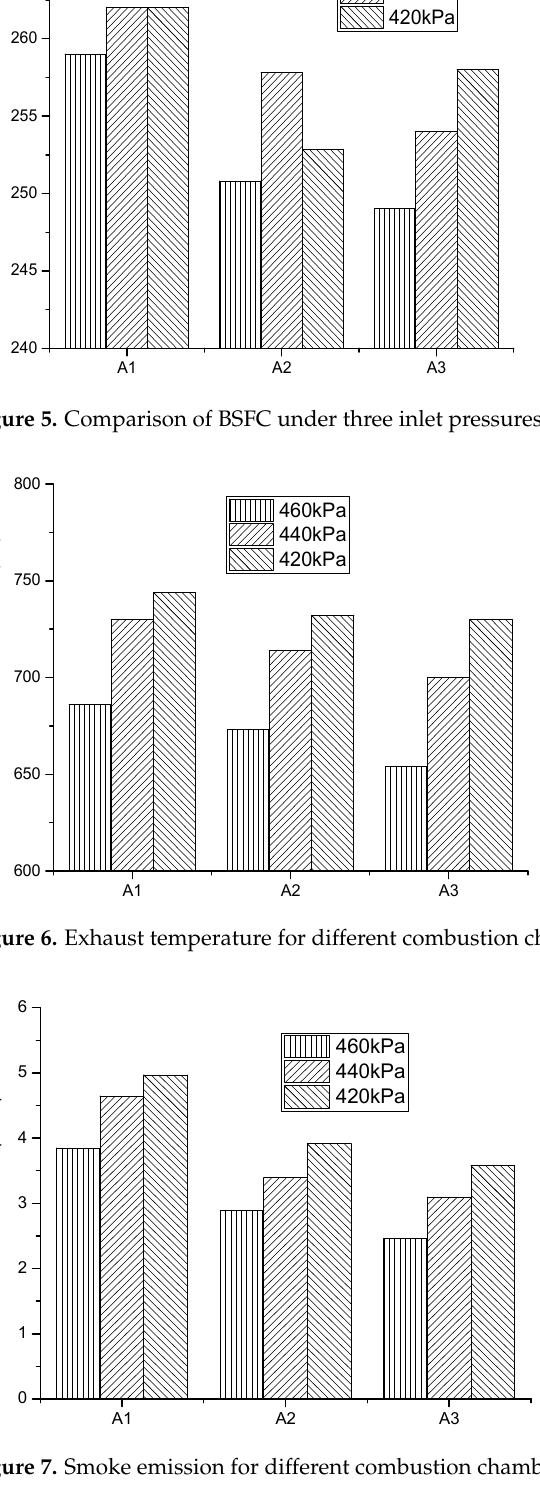
Figure 7. Smoke emission for different combustion chambers. According to the above analysis results, the BMEP of A2 RSCL combustion cham- ber with diameter of 72 mm is the largest, and BSFC, exhaust temperature, and smoke